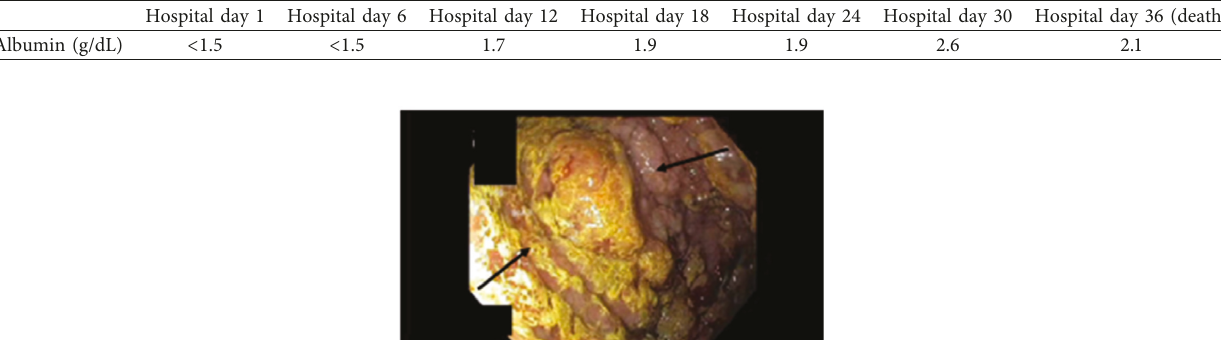
Table 1: The plateau of serum albumin levels.